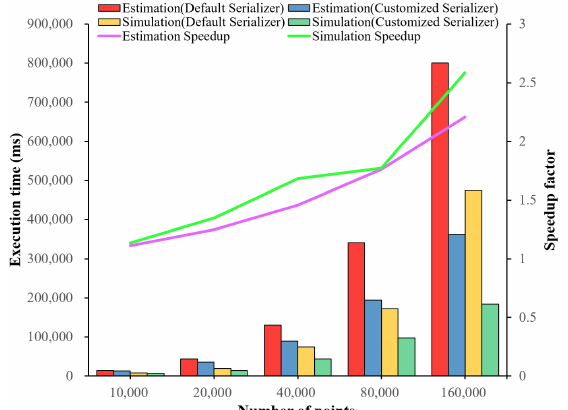
Figure 10. Performance comparison of cross K function with